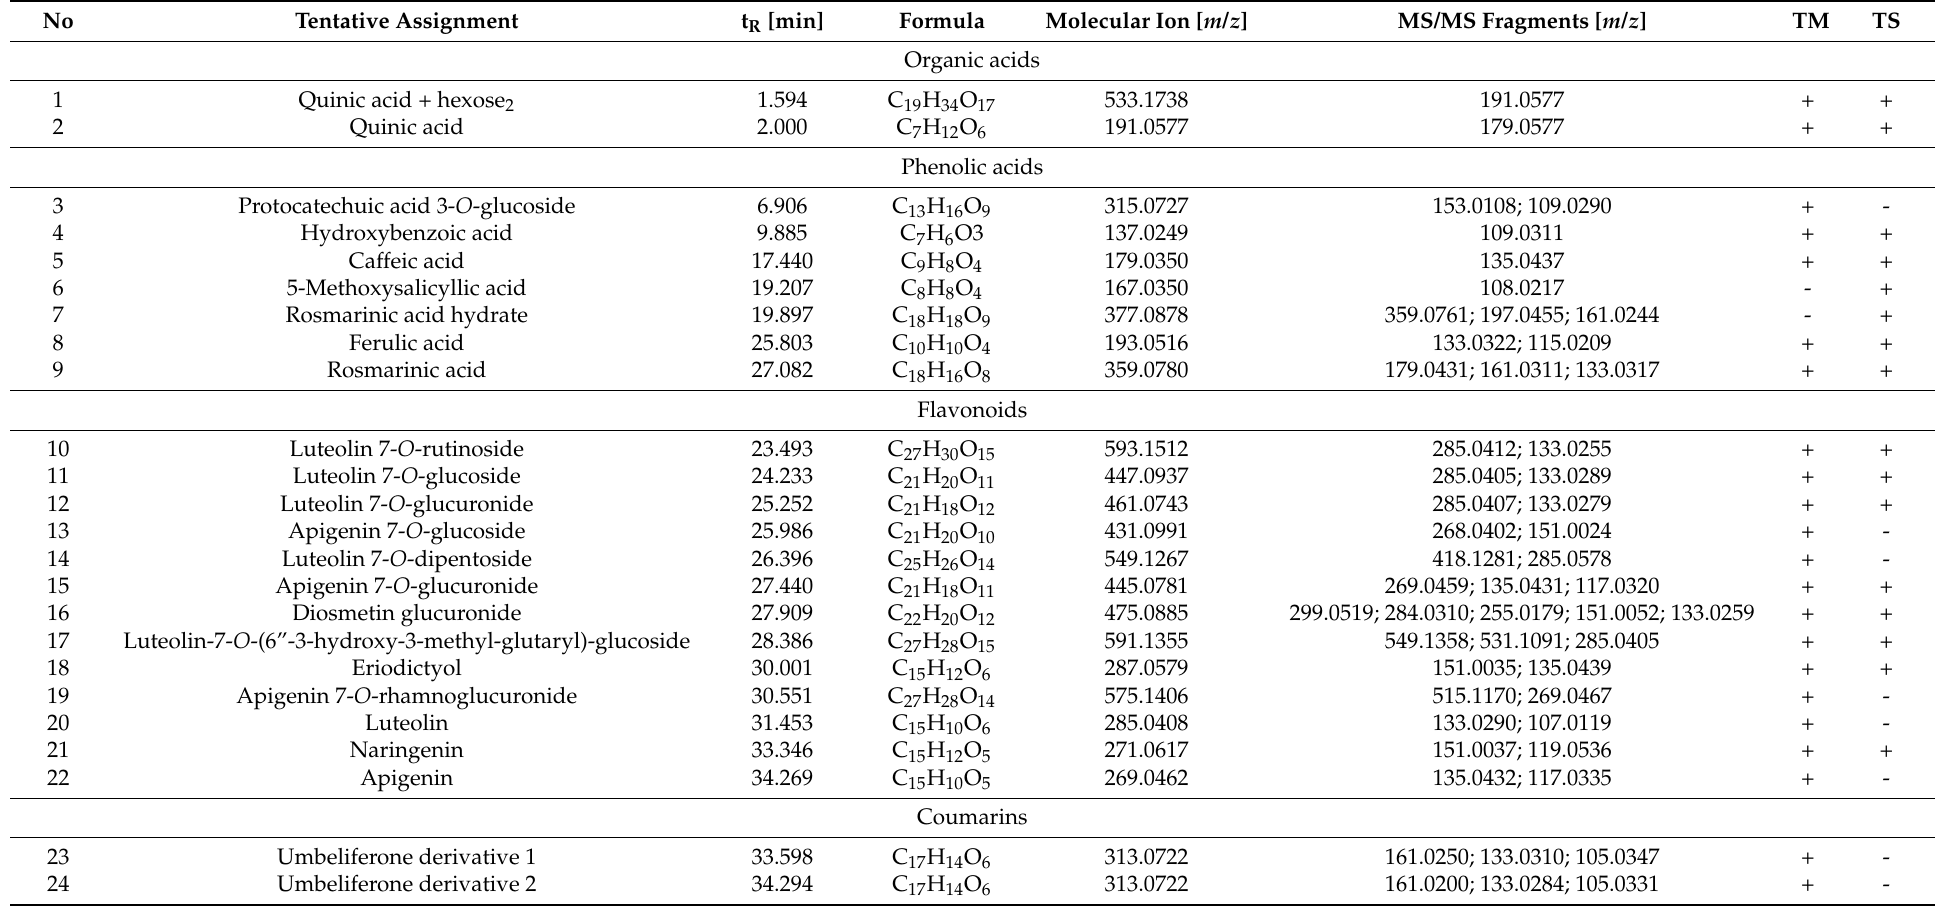
Table 1. Results of the HPLC/ESI-QTOF-MS analysis of the hydroethanolic extracts from the aerial parts of T. marschallianus (TM) and T. seravschanicus